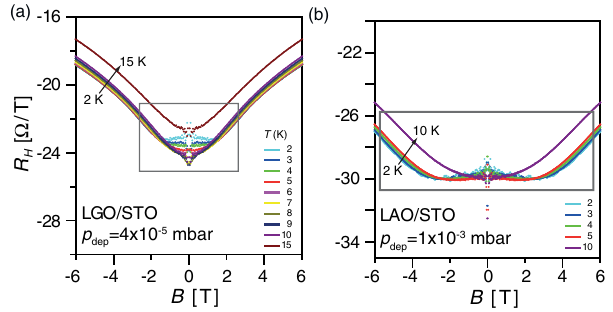
FIG. 11. Anomalous Hall effect observed in (a) LGO/STO 4 × 10 − 5 mbar and (b) LAO/STO grown at grown at p dep ¼ 1 × 10 − 3 mbar. Gray boxes are guides to the eye roughly p dep ¼ indicating the field range of the